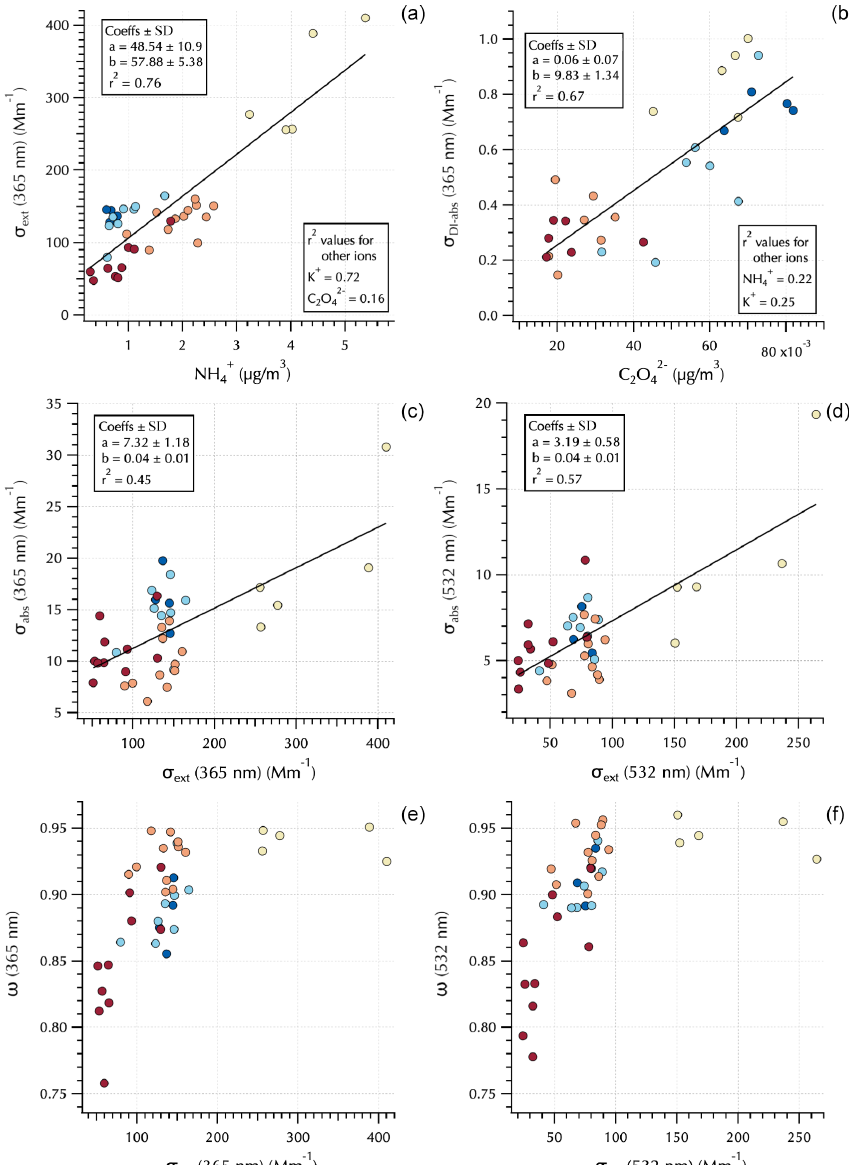
Figure 5. Relationships between 365nm σ ext and NH + tively), and ω and σ ext at 365 and 532nm ( e, f , respectively). Markers are colored by Peterson et al. (2019) meteorological regime (see Figs. 1 and